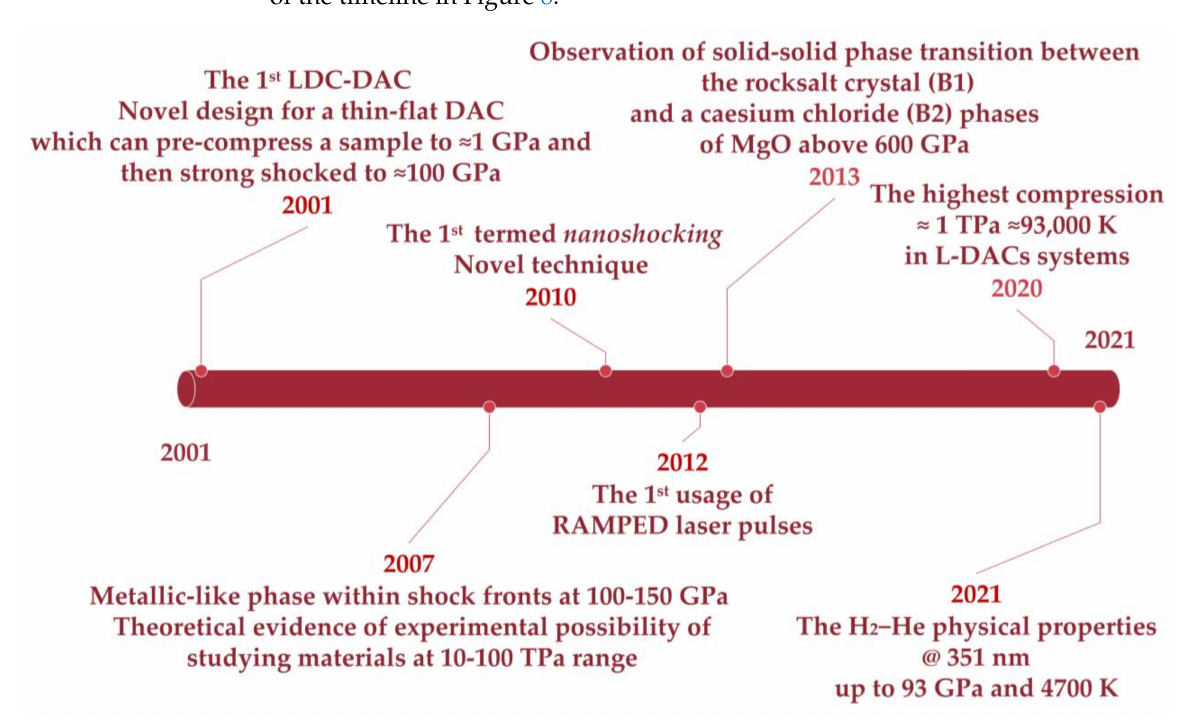
Figure 8. Chronology of key laser-generated shock compression diamond anvil cell (LDC–DAC) developments and